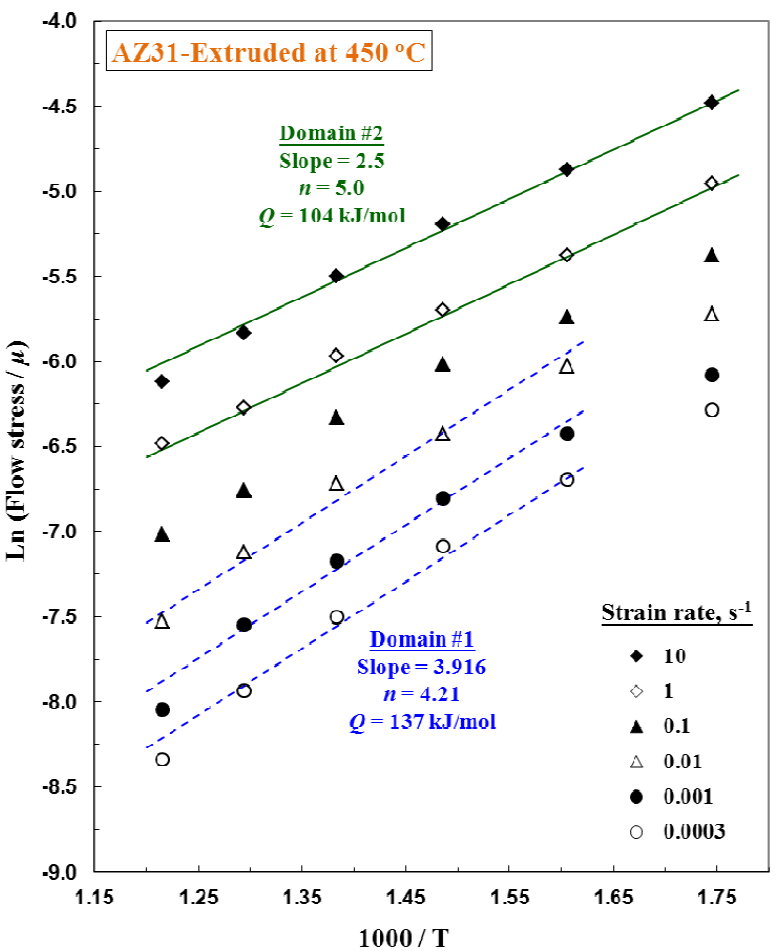
Figure 12. Arrhenius plot for calculating apparent activation energy in the two domains of processing map for AZ31 magnesium alloy extruded at 450